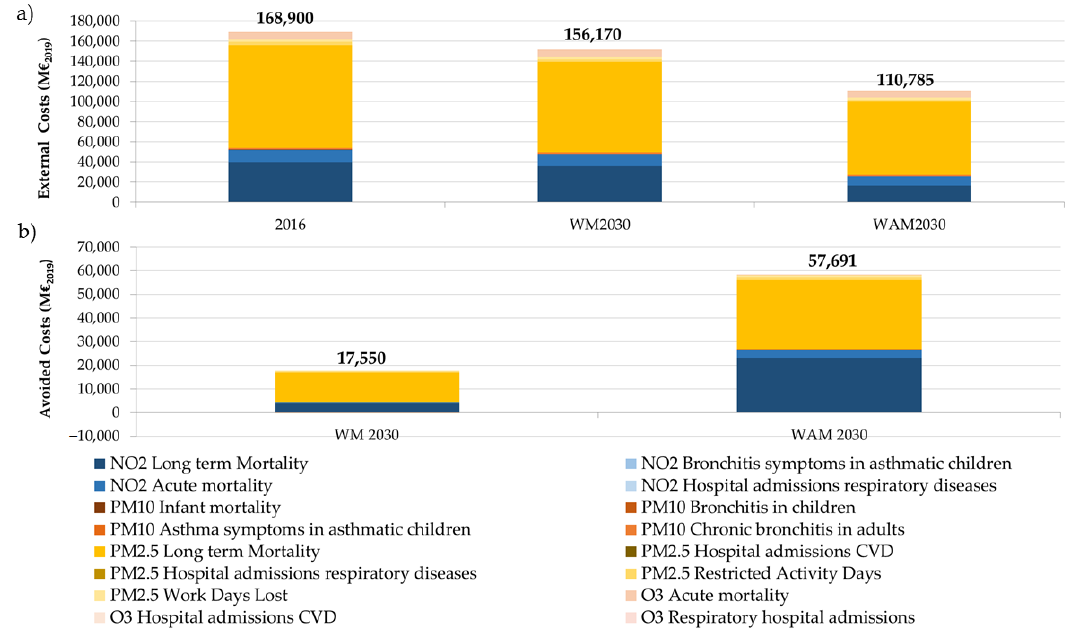
Figure 6. External costs associated with the assessed health impacts by pollutant, in M € 2019 , under the baseline scenario (2016) and the policy scenarios (WM2030 and WAM2030). The figure on the top ( a ) shows the total external costs associated with the health impacts for the pollutants and outcomes considered. The bottom figure ( b ) shows the external costs avoided by the implementation of the measures (WM2030 and WAM2030).